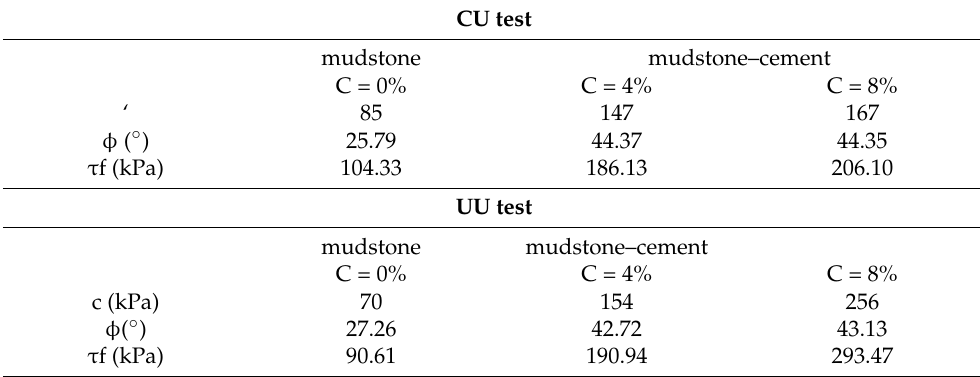
Table 1. Shear strength calculated by CU and UU test